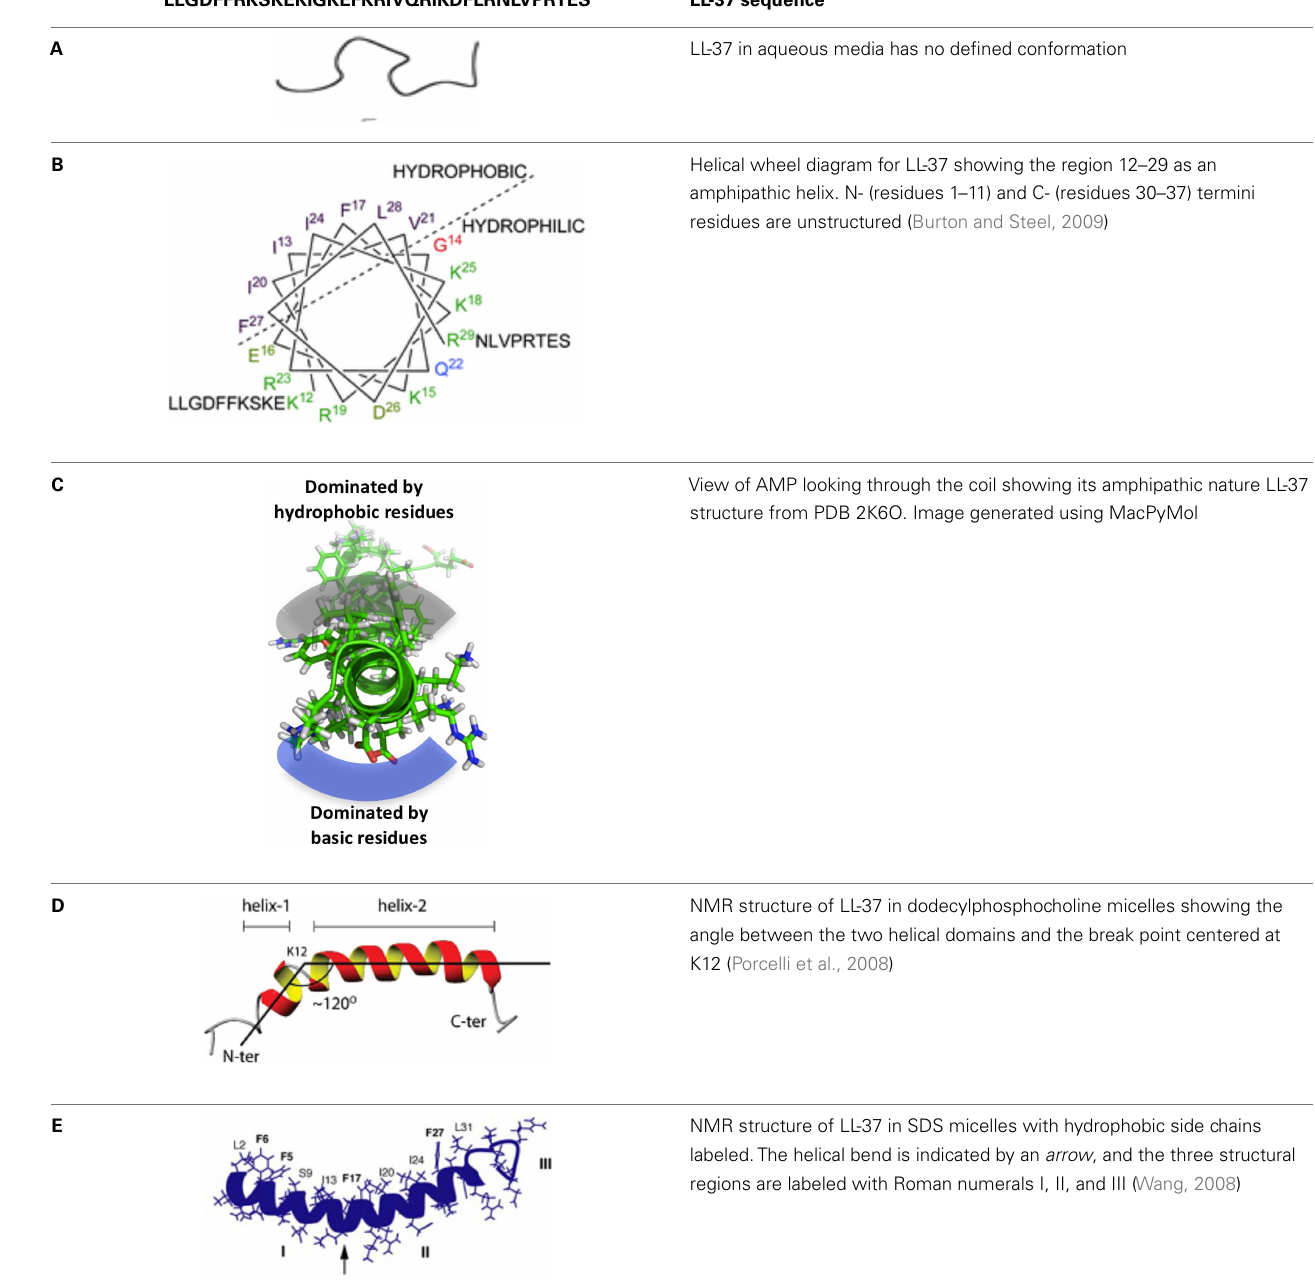
Table 1 | Secondary structure of LL-37.